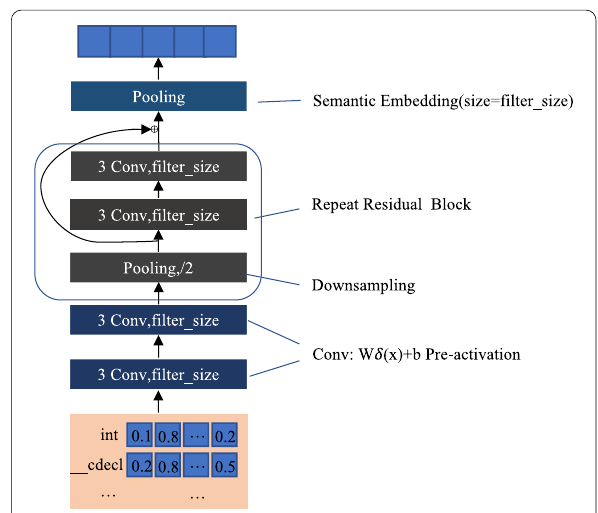
Fig. 6 The DPCNN model for extracting code and string